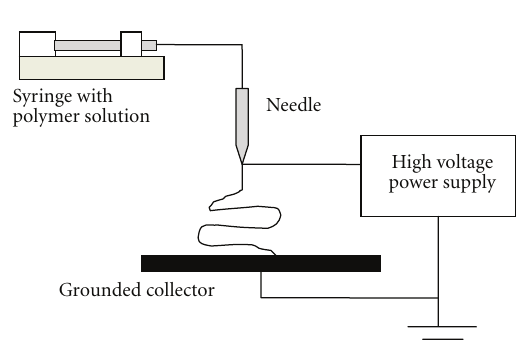
permeability calculated from a published correlation for fibrous